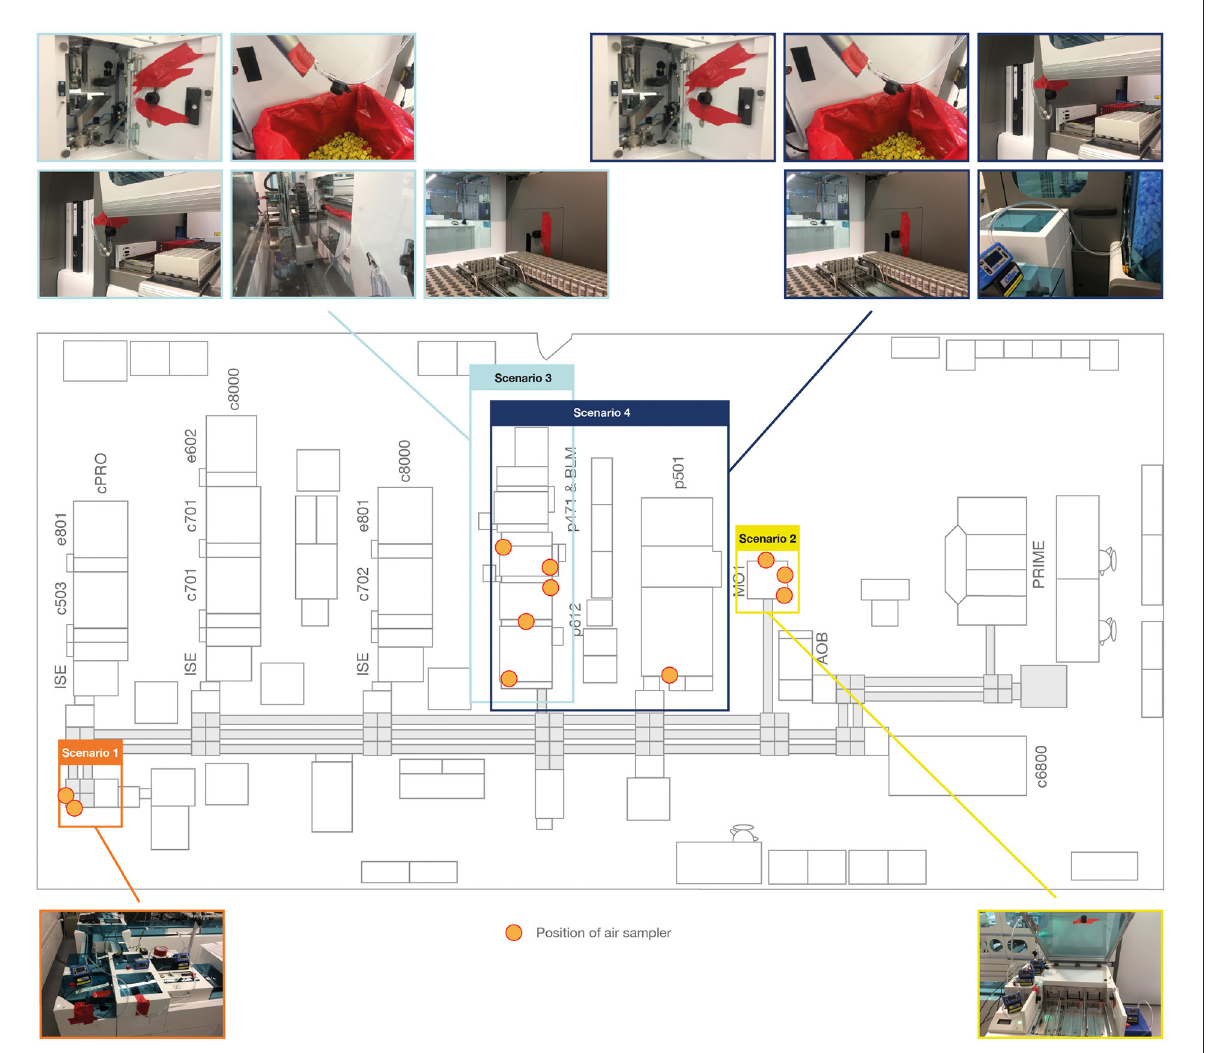
FIGURE2 Placement of air sampling units in the end-to-end laboratory workflow. AOB, add-on buffer unit; BLM, bulk loader module; cPRO, cobas pro; c503, cobas 503 clinical chemistry analyzer; c701, cobas 701 clinical chemistry analyzer; c702, cobas 702 clinical chemistry analyzer; c6800, cobas 6800 molecular analyzer; c8000, cobas 8000 modular analyzer; e602, cobas 602 immune analyzer; e801, cobas e 801 analytical unit; ISE, ion selective electrode module; MO1, manual output station 1; PRIME, cobas PRIME, pre-analytical system; p471, cobas p 471 centrifuge